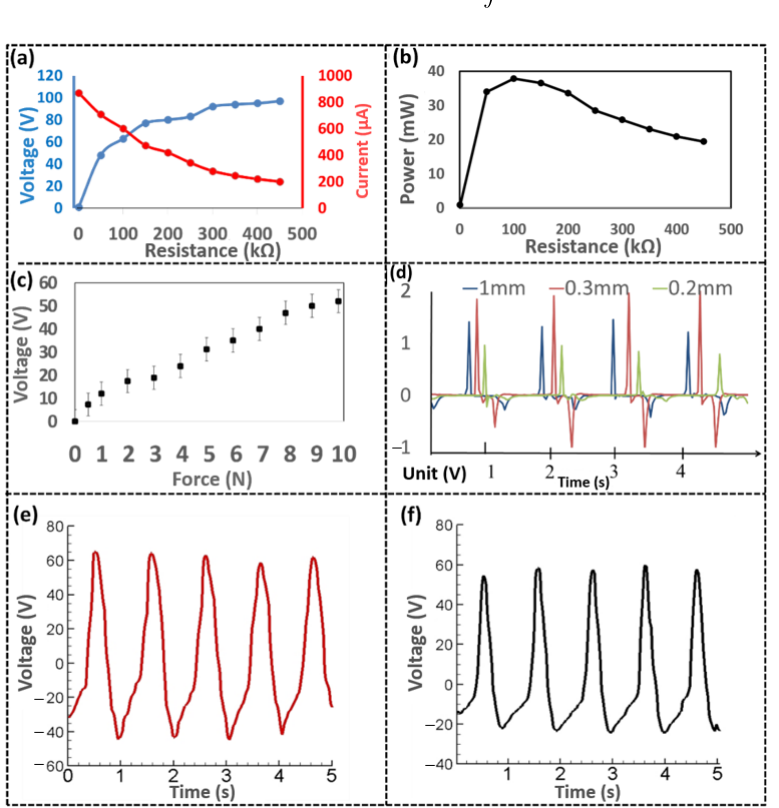
Figure 4. ( a ) Current and voltage output under different external load resistance. ( b ) Power output data. ( c ) The relationship between the applied force and the electrical voltage of the SPMS. ( d ) The voltage output comparison of the sensor by using different thicknesses of PTFE film. ( e ) Voltage output by pressing the front of the PENG, and ( f ) is the voltage output from pressing on the